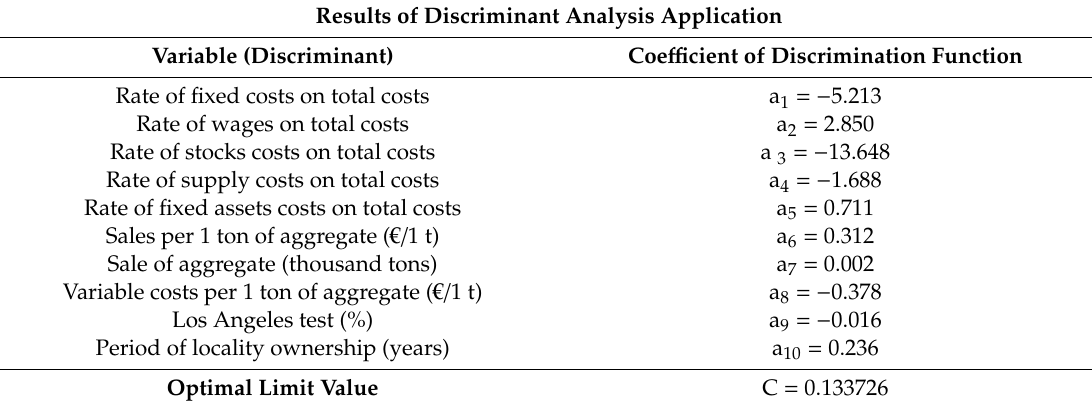
Table 5. Results of discriminant analysis